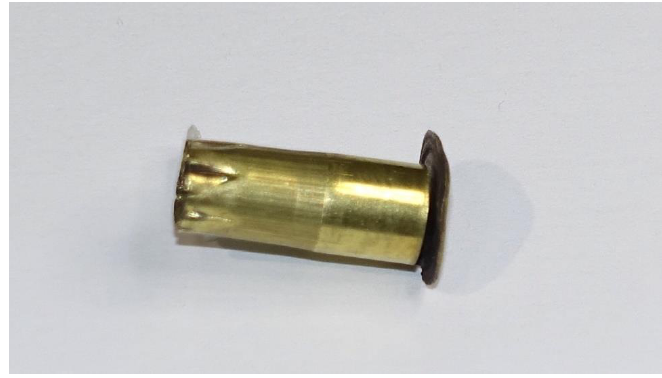
Figure 5. Example of cartridge (AS head stamped) post shot that split at the primer flange.